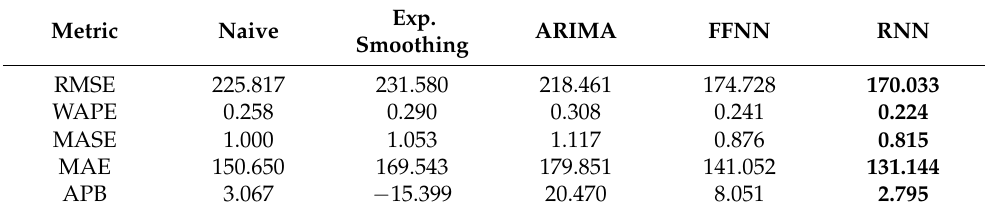
Table 3. Baseline and deep learning methods performance.